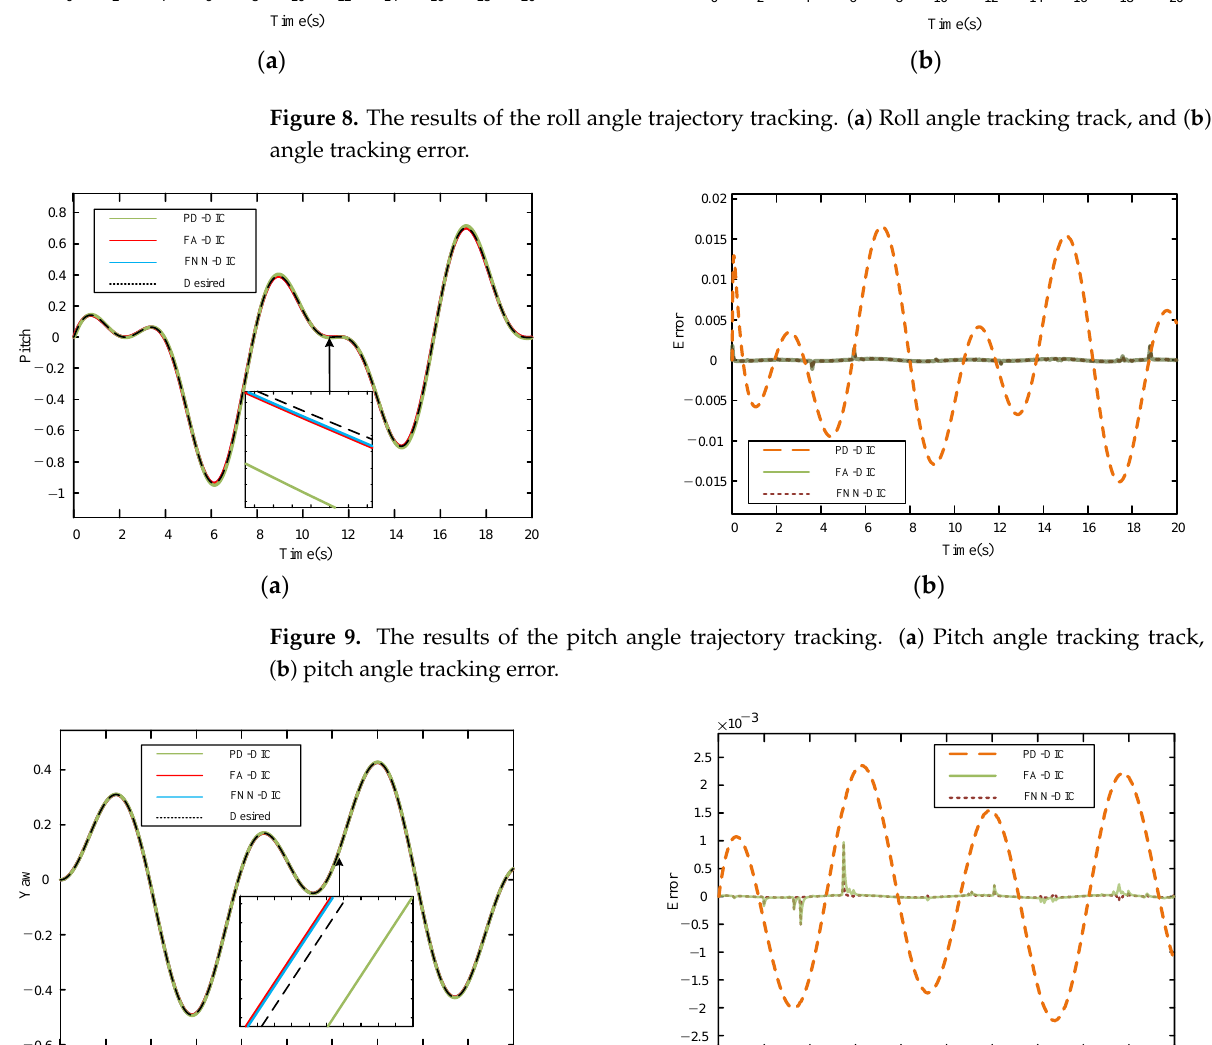
( b ) Figure 11. Roll angle tracking results under atmospheric disturbance: ( a ) Roll angle tracking curve, and ( b ) tracking error curve.